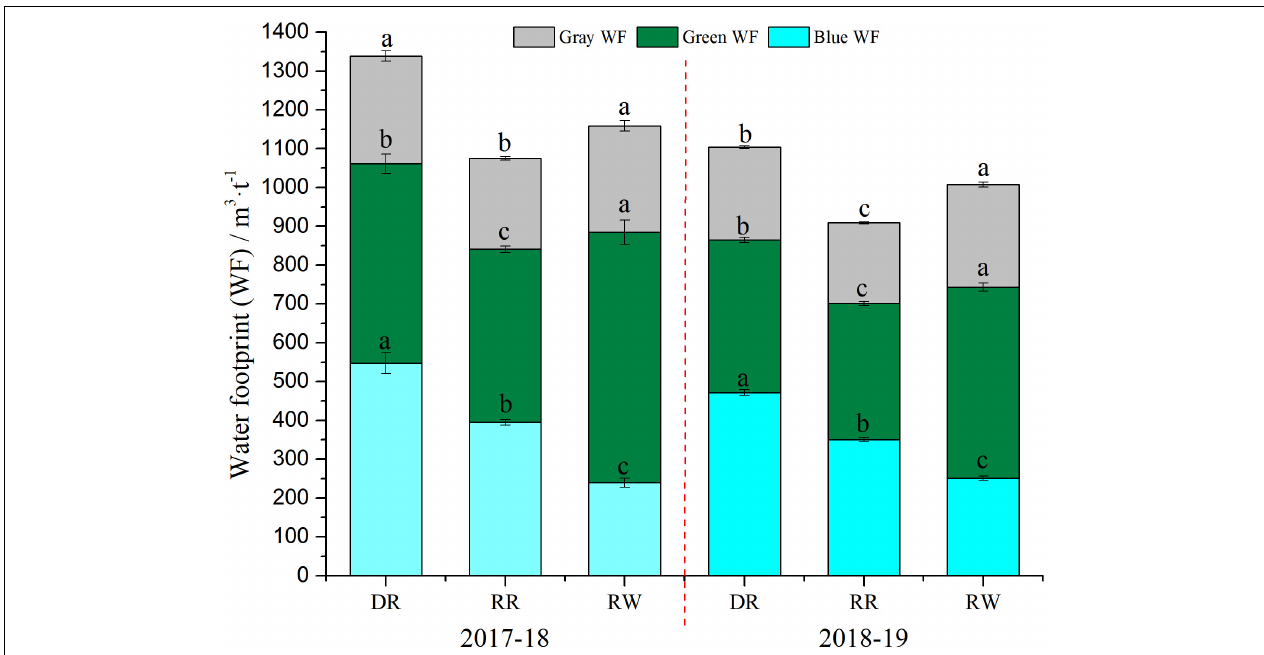
FIGURE 5 | Water footprint for the three rice cropping systems. DR, double-rice system; RR, ratoon rice system; RW, rice-wheat system. Different lower-case letters indicate the significant differences ( P < 0.05) in a same individual water footprint.